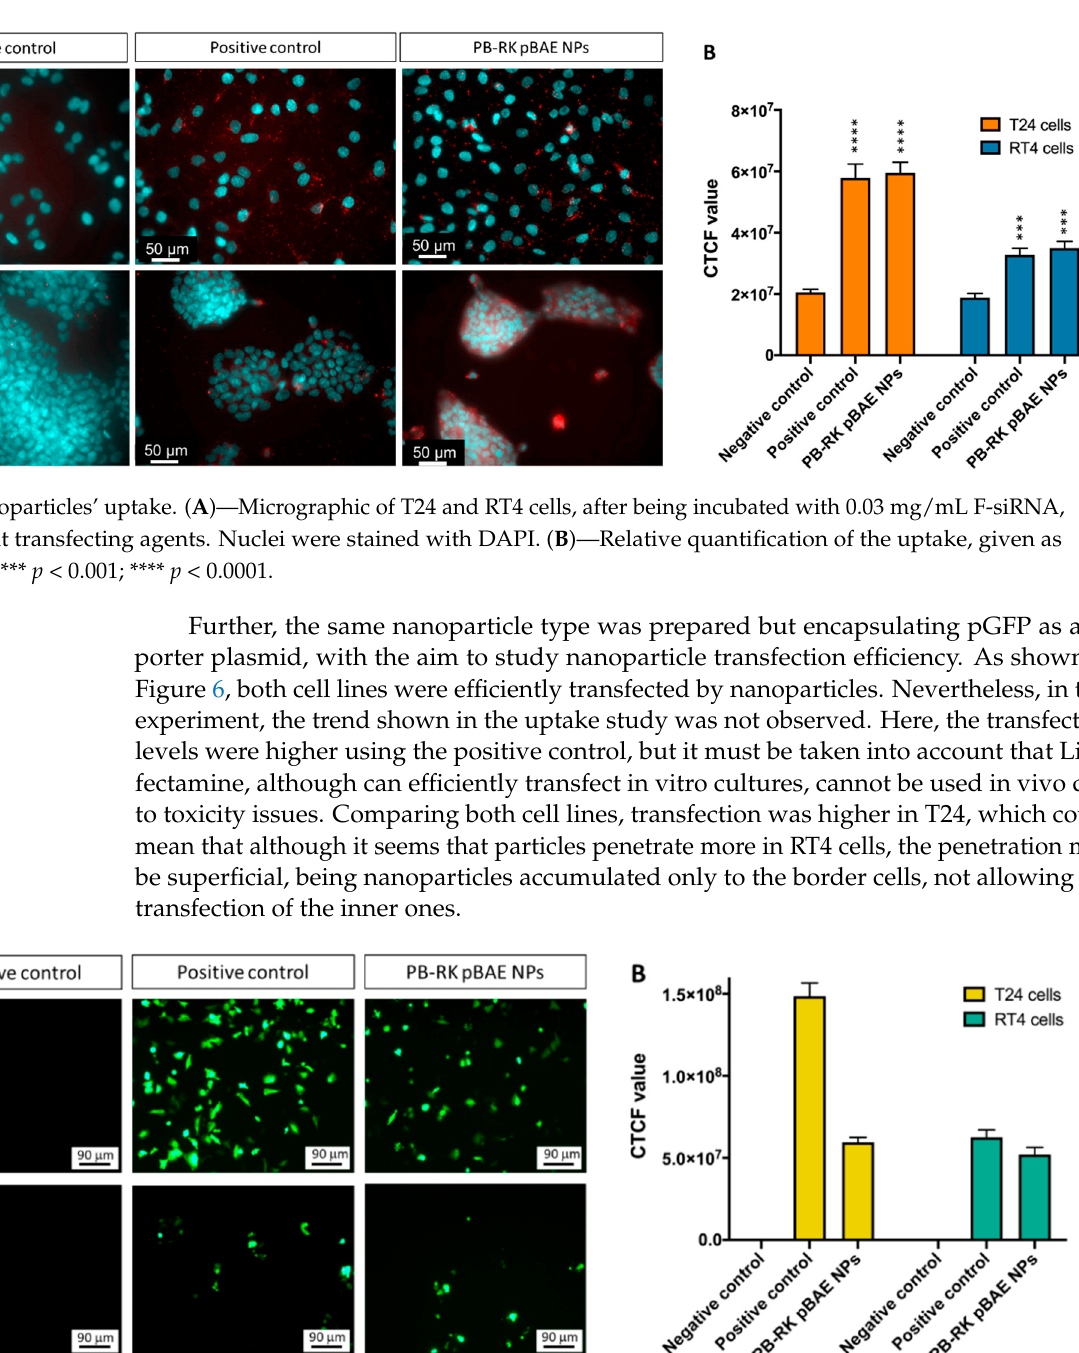
pGFP, using different transfecting agents. Positive control was performed with Lipofectamine 2000. ( B )—Relative quantification of